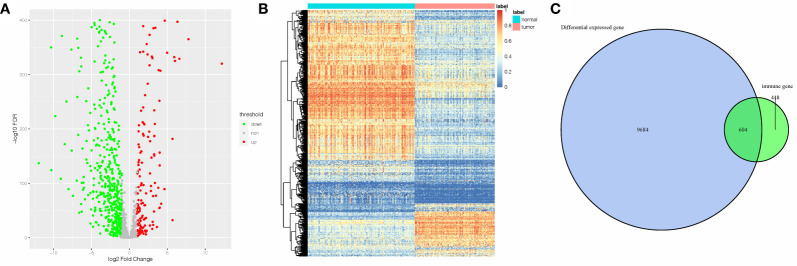
A total of 605 AML-related IRGs are shown in the (A) volcano plot, (B) heatmap, and (C) AML-related IRGs.